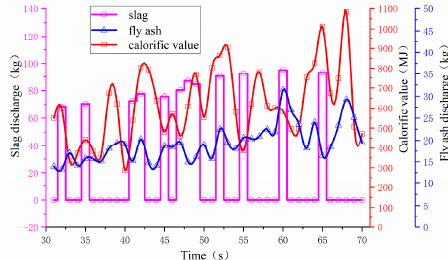
Figure 26. Dynamic changes of fly ash, slag and calorific value (30~70 s).